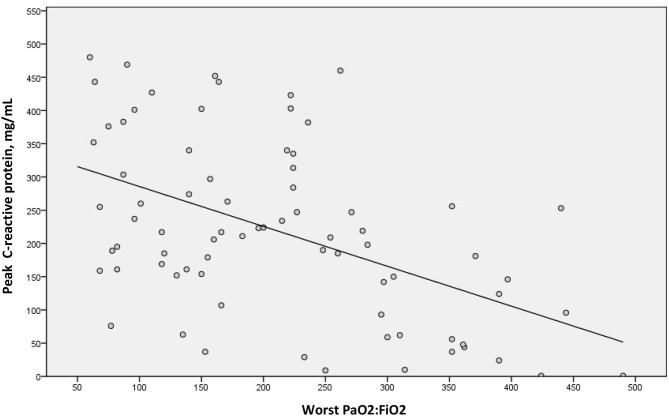
Correlation between highest C-reactive protein and worst PaO2:FiO2 during hospital stay in patients with COVID-19 and suspected pulmonary embolism (rs = −0.473; p < 0.001).